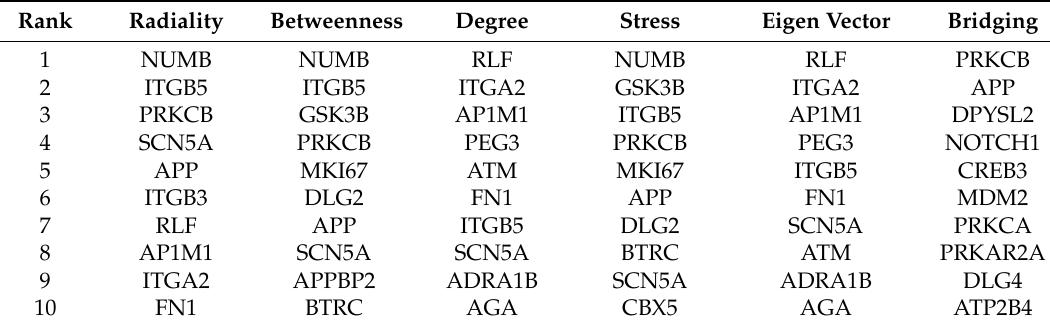
Table 5. The top 10 proteins ranked by centrality values.